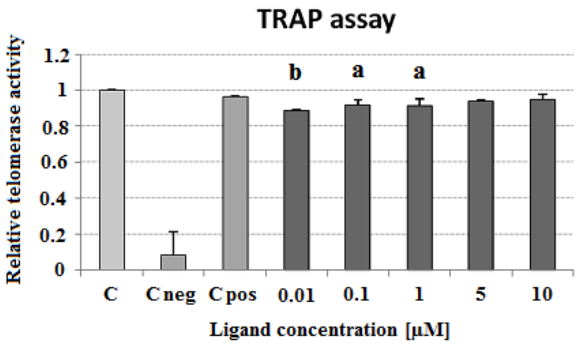
Figure 13. Influence of carbazole derivative 3 on telomerase activity in a cell-free telomerase repeat amplification protocol (TRAP) assay. C, control cell extract; C neg, negative cell extract; C pos, positive cell extract. p < 0.05 (a), p < 0.01 (b).